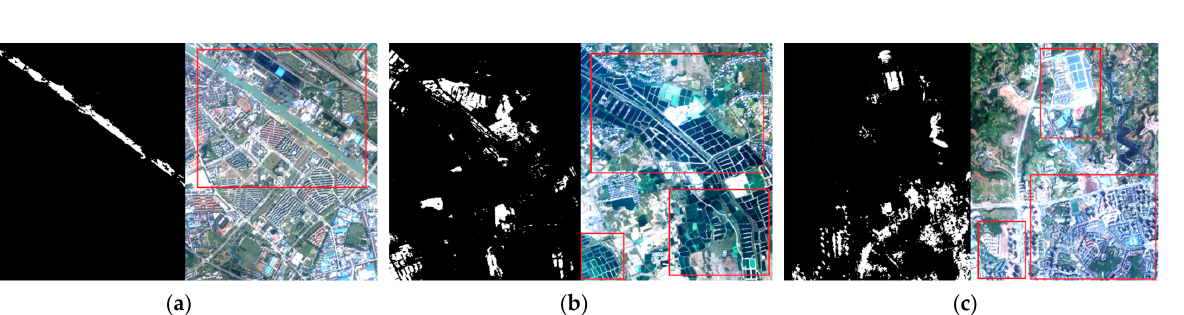
Figure 3. Prediction results of ten validation images.